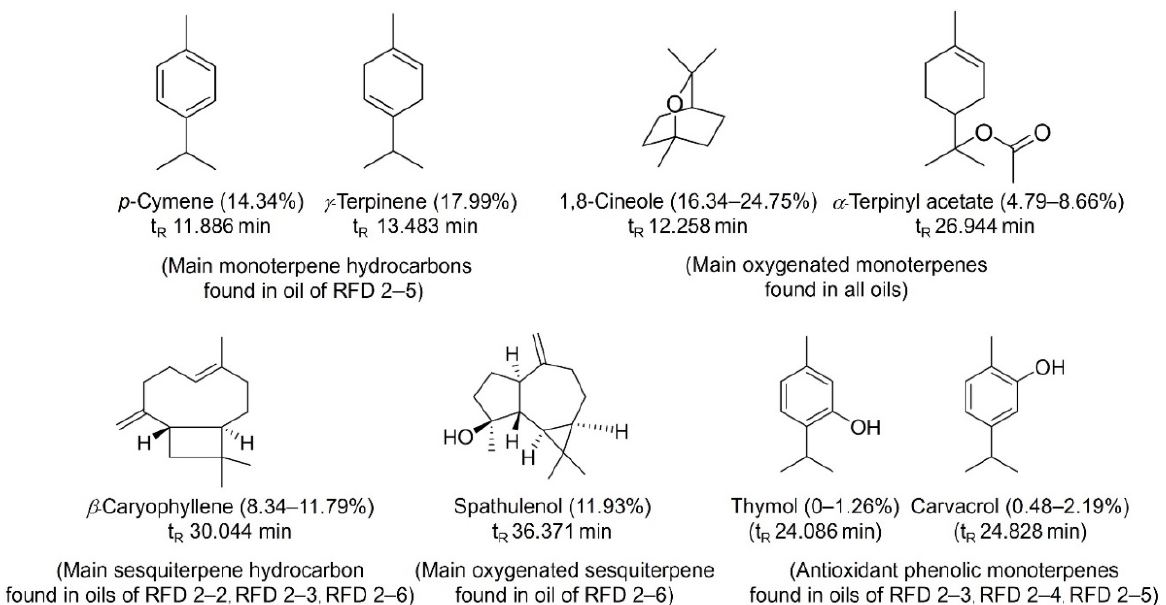
Figure 1. Chemical structures of main terpenoids and phenolic terpenoids found in essential oils of the E. urophylla clones (RFD 2–2, RFD 2–3, RFD 2–4, and RFD 2–6) and the E. urophylla × E.